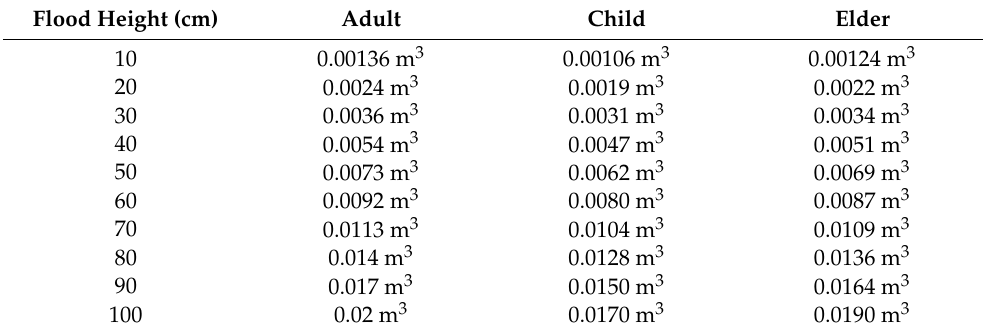
Table 10. The drainage volume of all groups in flood at different flood heights. Flood Height (cm) Adult